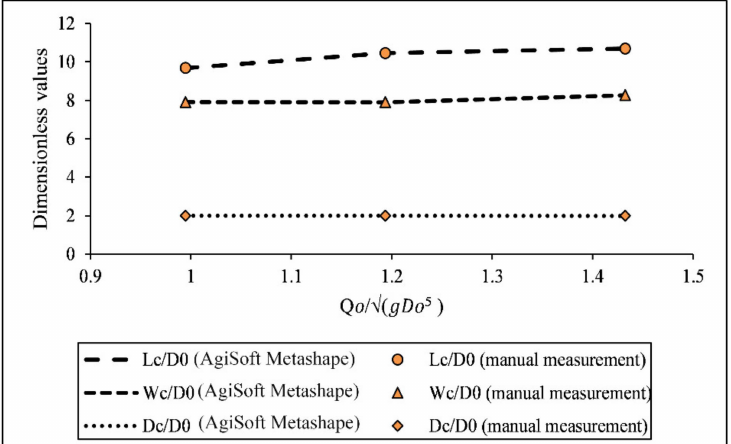
Figure 5. Output data from AgiSoft Metashape based on the best DBE structure in a full-obstruction situation using various indices of flow (dimensionless) compared with the manually measured data.